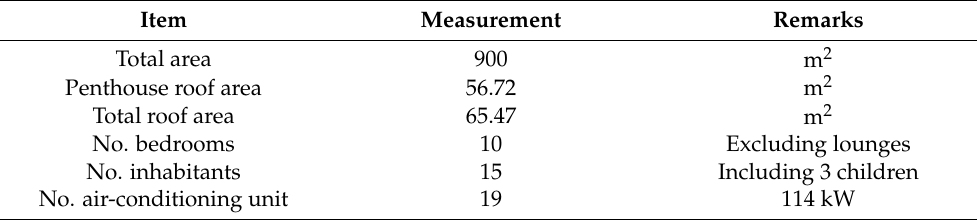
Table 1. Home Specification.